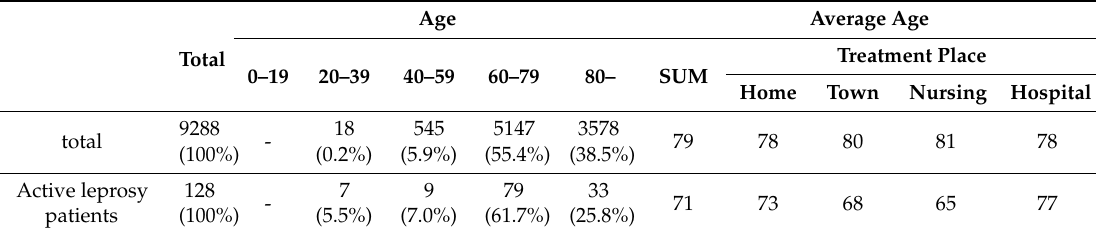
Table 3. Age distribution of Hansen’s disease in Korea (2019): Hansen’s disease status and major indicators.